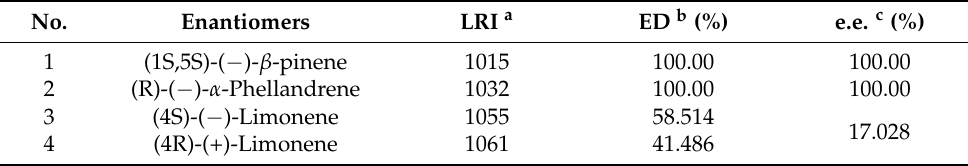
Table 2. Enantioselective analysis of the M. discolor EO.